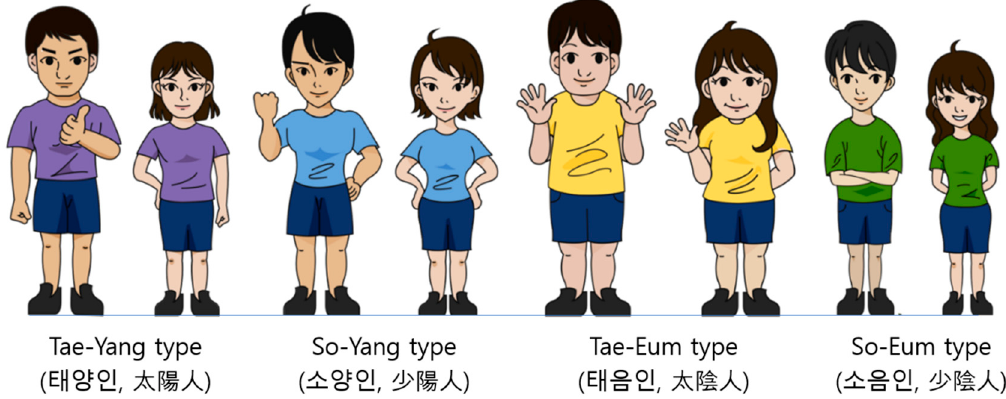
Figure 1. Illustrated figures of four Sasang